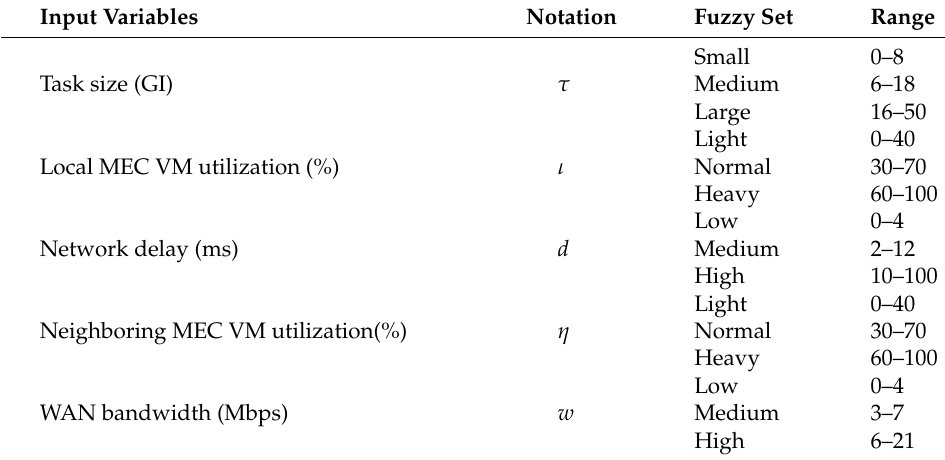
Table 2. Fuzzification input variables